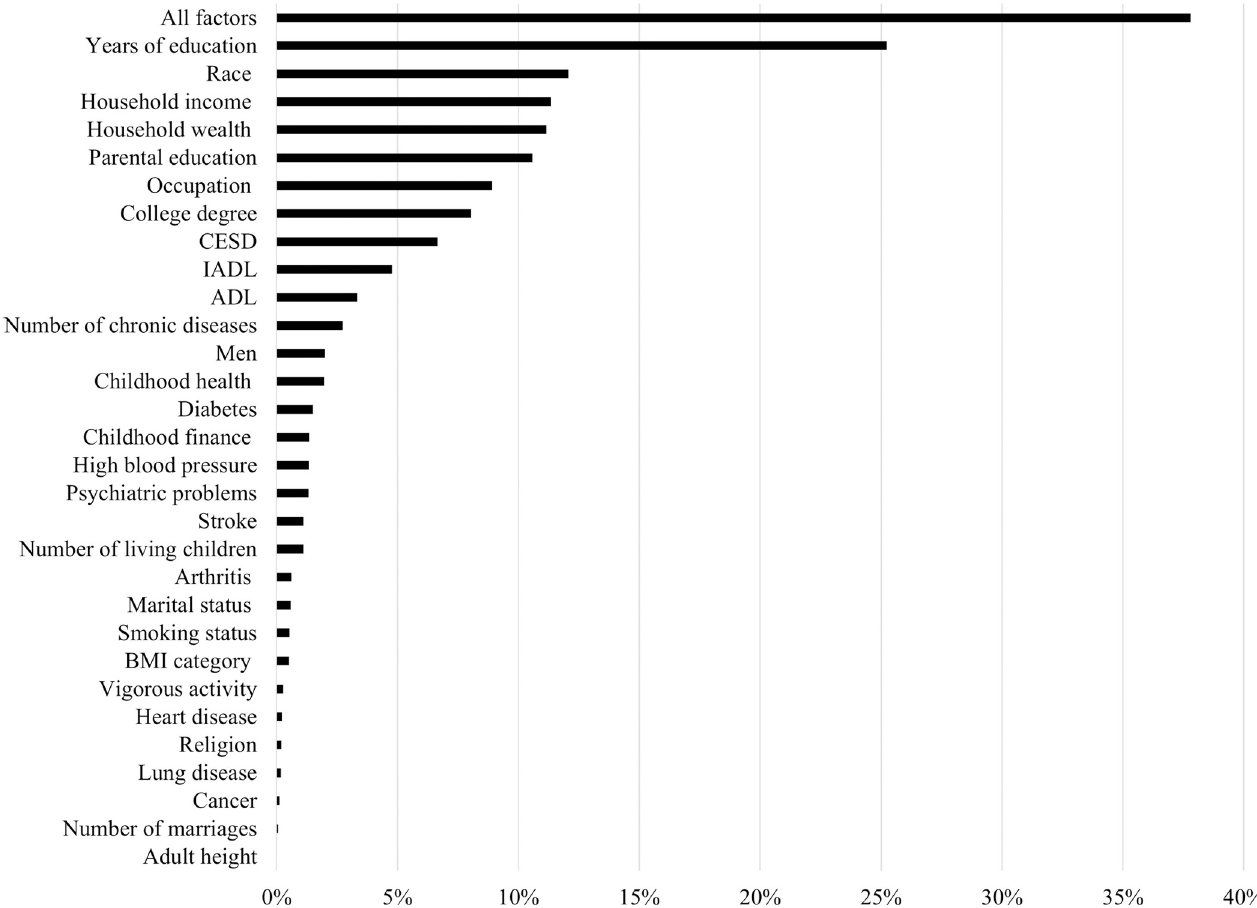
Fig 2. Percentage changes in between-person residual variance in intercept from unconditional growth model to subsequent models of Table 2.